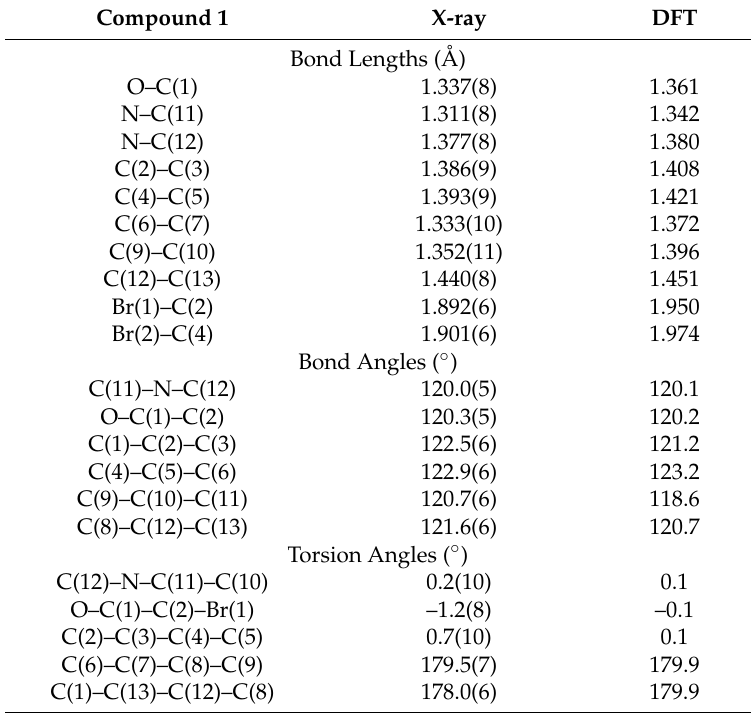
Table 2. Comparison of the experimental and optimized geometric parameters of 1 (Å and ◦ ). DFT: Density Functional Theory.